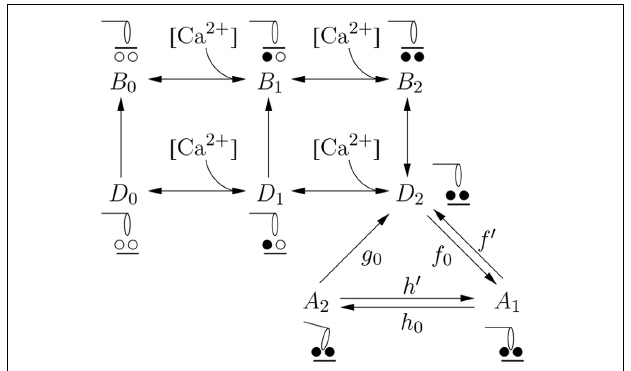
FIGURE 1 | The cross-bridge dynamics model. The reader is referred to the text for explanations.